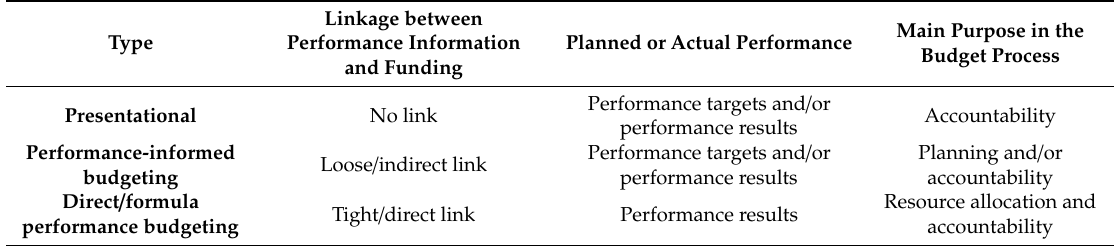
Table 1. Performance budgeting models.